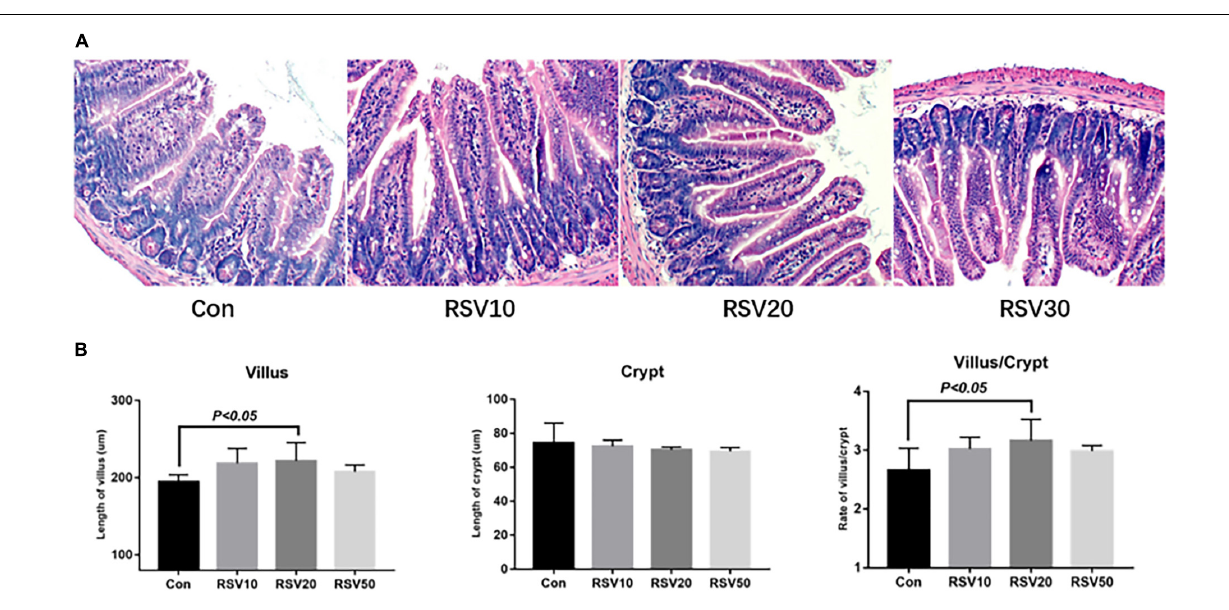
FIGURE 2 | Effect of RSV on intestinal morphology of weaned mice. (A) Ileum morphology of mice in each group was evaluated by hematoxylin and eosin (HE) staining. (B) Villus length, crypt depth, and the ratio of villus length to crypt depth of RSV-treated mice. Con = control group, RSV10 = 10 mg/kg RSV, RSV20 = 20 mg/kg RSV, RSV50 = 50 mg/kg RSV. All the data are expressed as the means ±